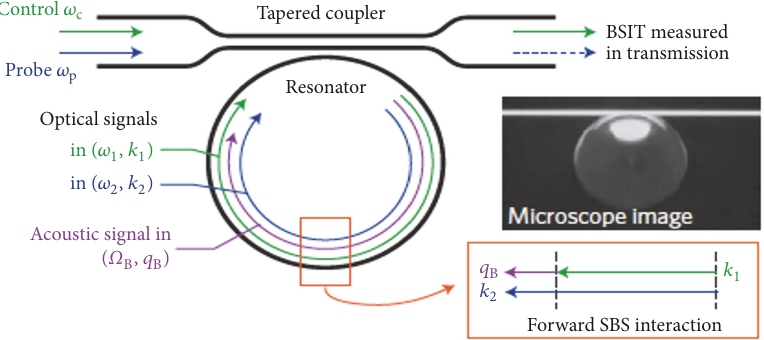
Figure 16: Geometry of tapered fiber coupler to the transparent sphere, plus a photograph of the coupler [adapted from [18]].